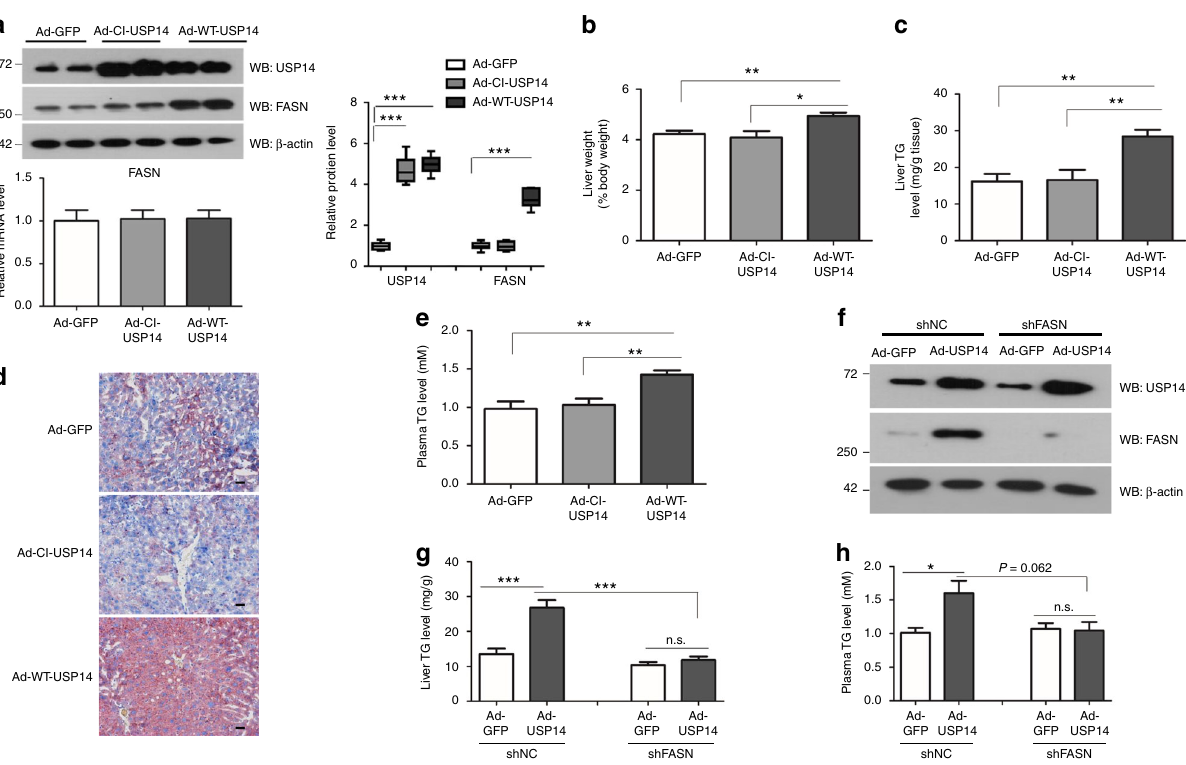
Fig. 6 Overexpression of USP14 promotes hepatosteatosis. a Overexpression of hepatic USP14 in C57BL/6 mice infected with adenoviral wild-type (WT) USP14, catalytic inactive (CI) USP14, or green fl uorescent protein (GFP) by western blot (up) and quantitative real-time PCR (bottom) ( n = 6 for each group). The two lanes are two representative biological replicates. Each lane represents the tissue protein sample from one mouse. A representative western blot was shown and with the quanti fi cation plot based on scanning densitometry analysis (right). *** p < 0.001 versus indicated groups (Student ’ s t -test). b , c Liver weight b , hepatic TG contents c in three groups of mice. d Representative hepatic histology by Oil Red O staining from mice overexpressing GFP, CI-USP14, or WT-USP14, scale bar 100 μ m. e Plasma TG levels in three groups of mice. f Representative protein levels of USP14 in mice administrated with adenovirus as indicated. g , h Hepatic and plasma TG contents in four groups of mice. After a 16-h fast, mice were killed at day 10. Two-way ANOVA was used for statistical analysis. Data are presented as mean ± SEM. * p < 0.05; ** p < 0.01; *** p <